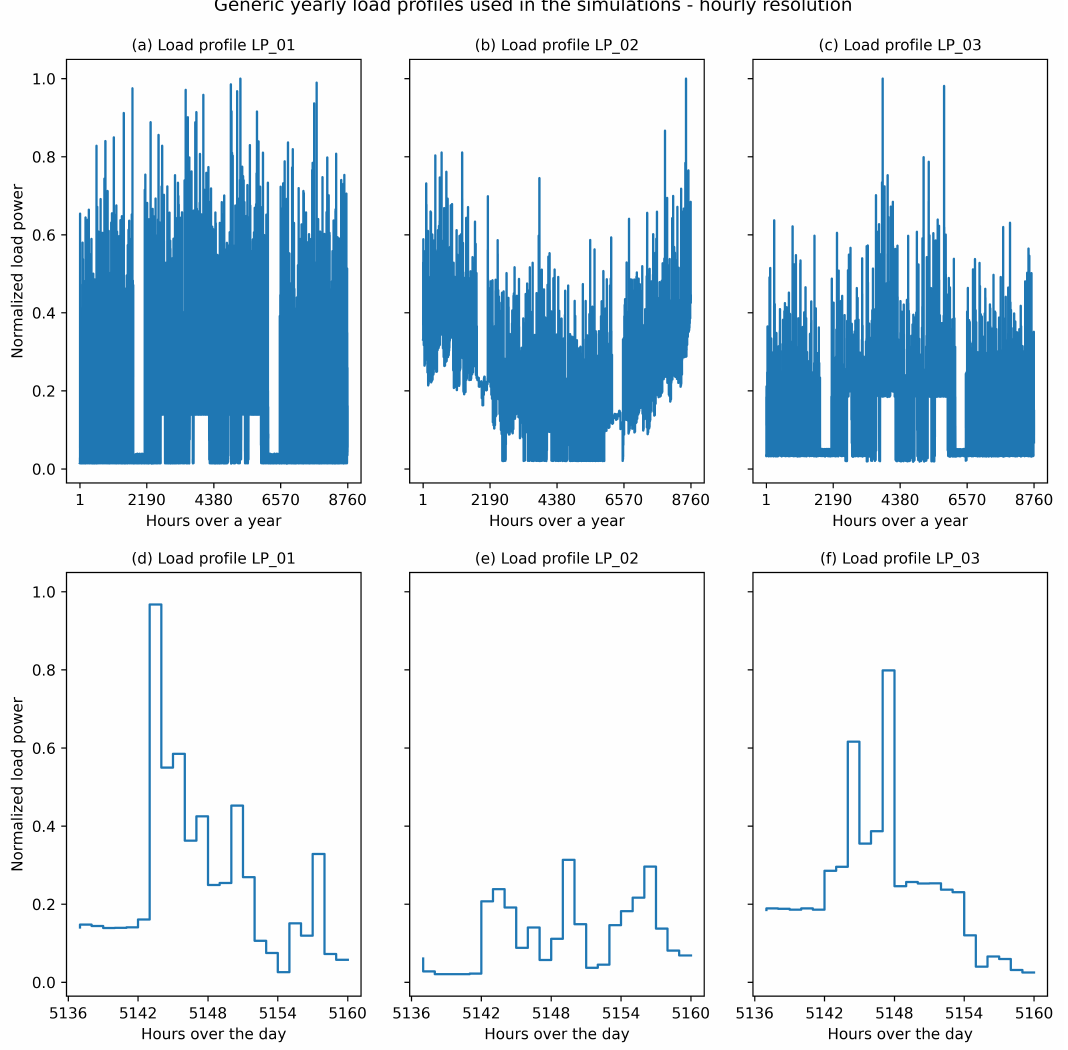
Figure 8. Input data—load shapes: ( a ) LP 01-year; ( b ) LP 02-year; ( c ) LP 03-year; ( d ) LP 01-day; ( e ) LP 02-day; ( f ) LP 03-day.